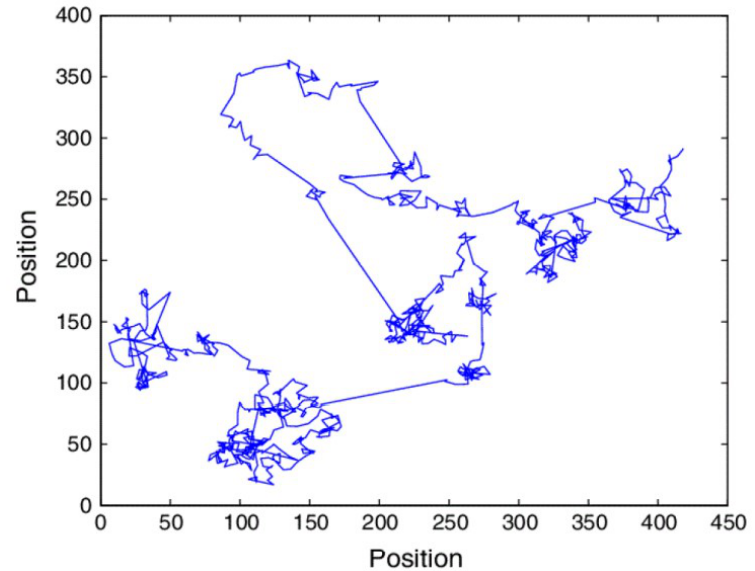
Figure 9. The landing sites for the WRW are connected by jumps and the islands of clusters discussed in the text are readily observed. From [150] with